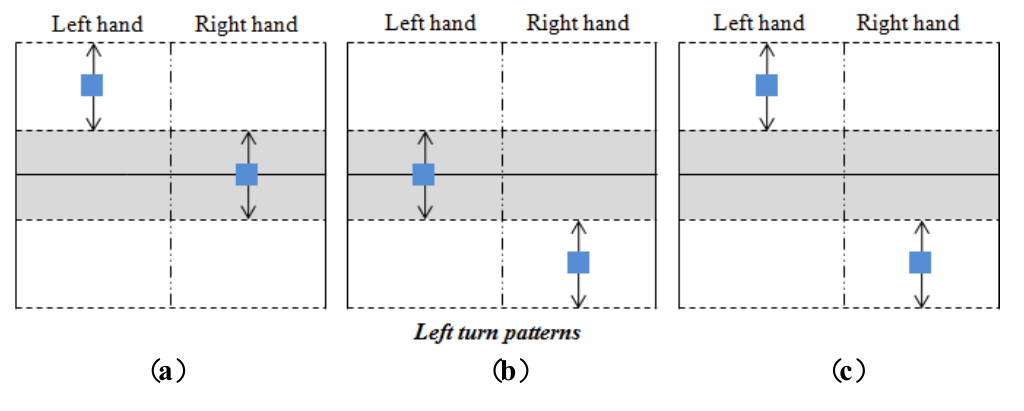
Figure 13. Left turn patterns.